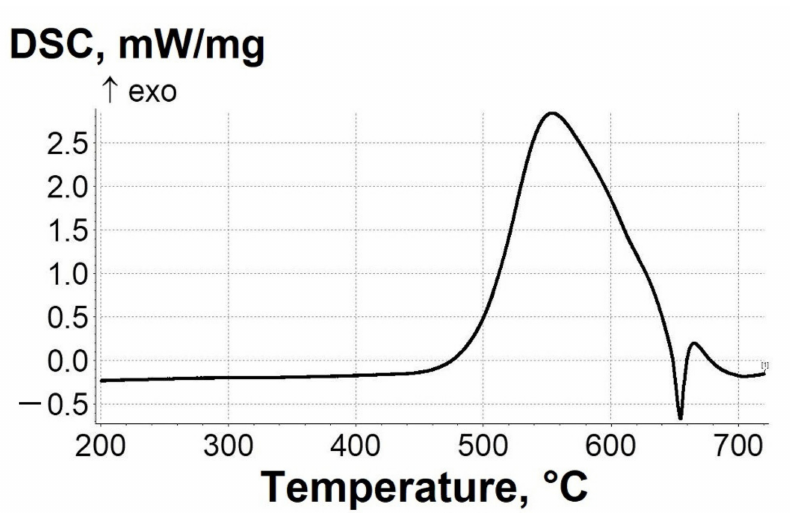
Figure 4. Results of DSC study of nanocomposite “Al + 25% ND”: exo-peak is the result of Al 4 C 3 formation; endo-peak is the result of aluminium